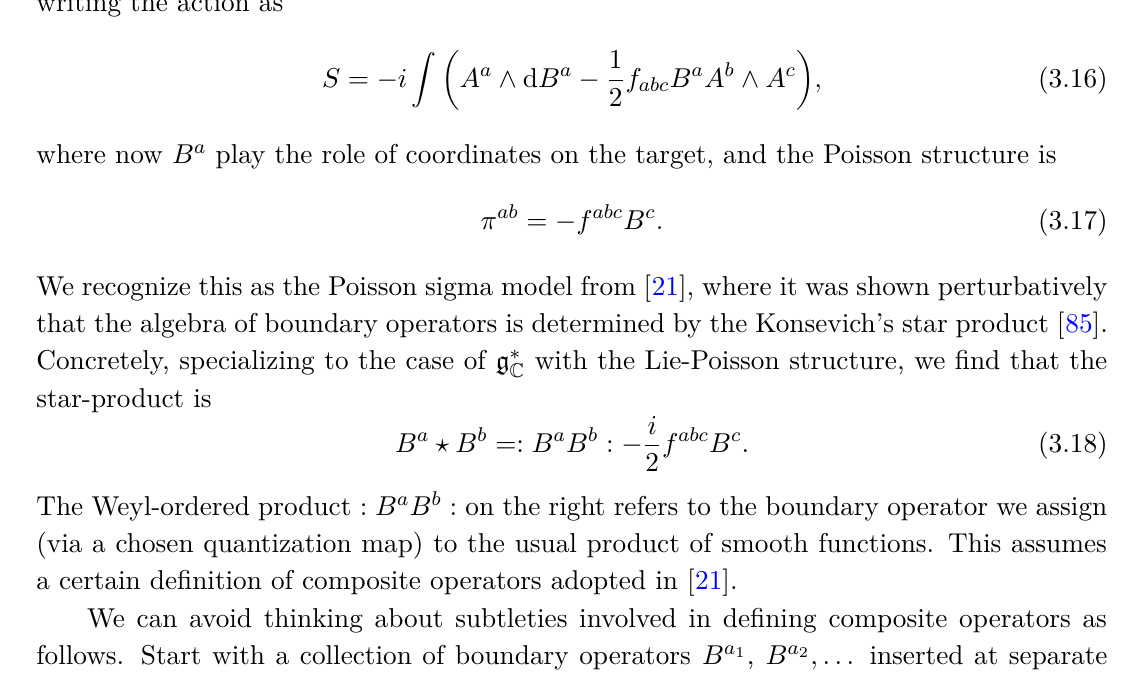
− x → 0 limit, only the n = k = 0 , 1 2